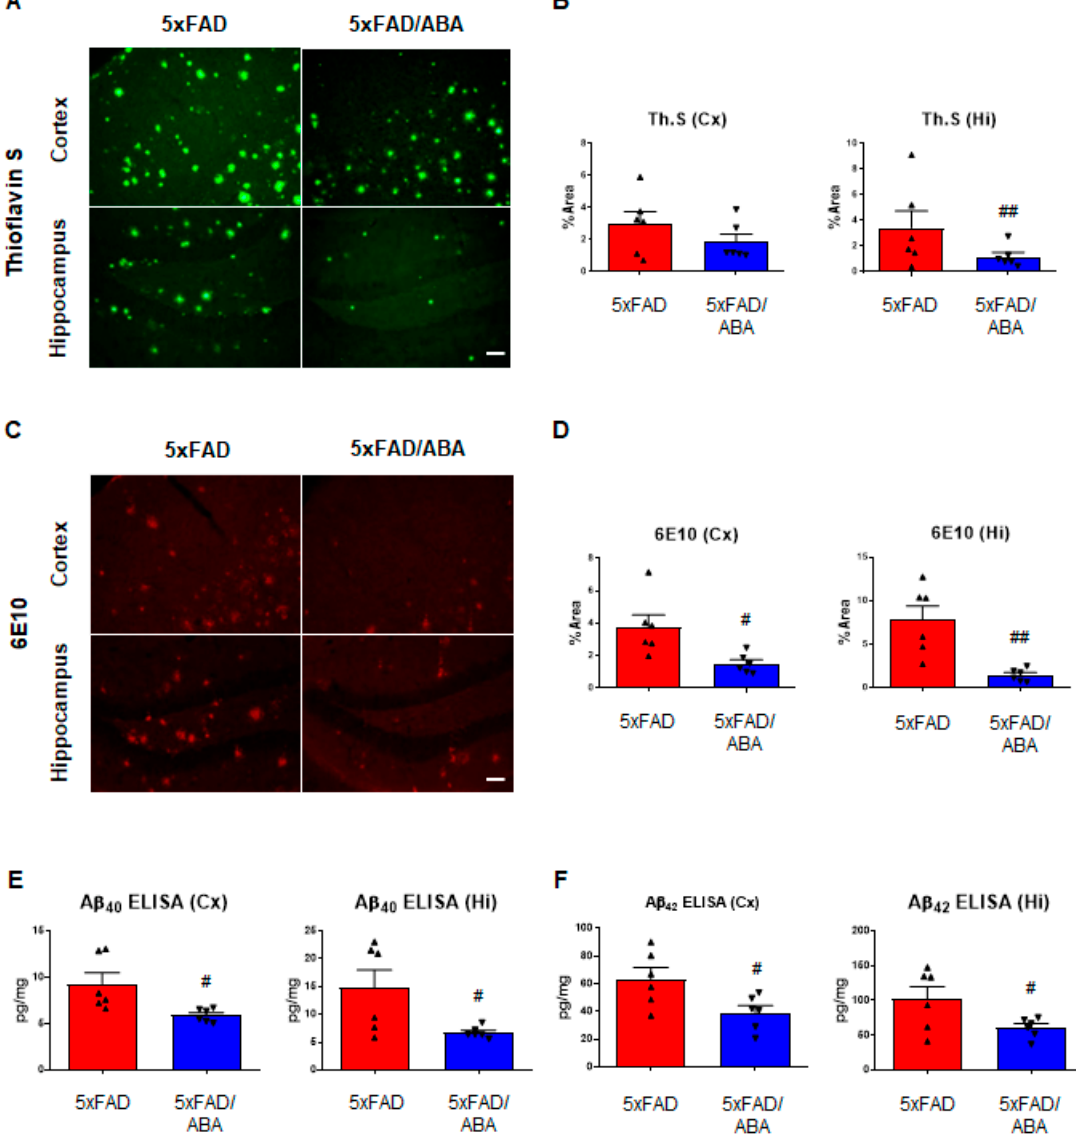
Figure 2. ABA reduces amyloid-beta (A β ) deposition in 5xFAD mice brains. ( A ) Representative images of Thioflavin S (ThS) staining (scale bar = 50 µ m). ( B ) Quantification of ThS positive area in the cortex and hippocampus of ABA-treated or nontreated 5xFAD mice. ( C ) Representative images of 6E10 staining, which detects the A β 1–16 peptides (scale bar = 50 µ m). ( D ) Quantification of 6E10 positive areas in the cortex and hippocampus of the ABA-treated or nontreated 5xFAD mice. ( E , F ) Results of enzyme-linked immunosorbent assay (ELISA). Levels of ( E ) A β 40 and ( F ) A β 42 in the cortex and hippocampus of 5xFAD mice brains. All data are expressed as the mean ± S.E.M. ( n = 6). Statistics were analyzed by Student’s t test. # p < 0.05, ## p < 0.01, significantly different from the vehicle-treated 5xFAD group.